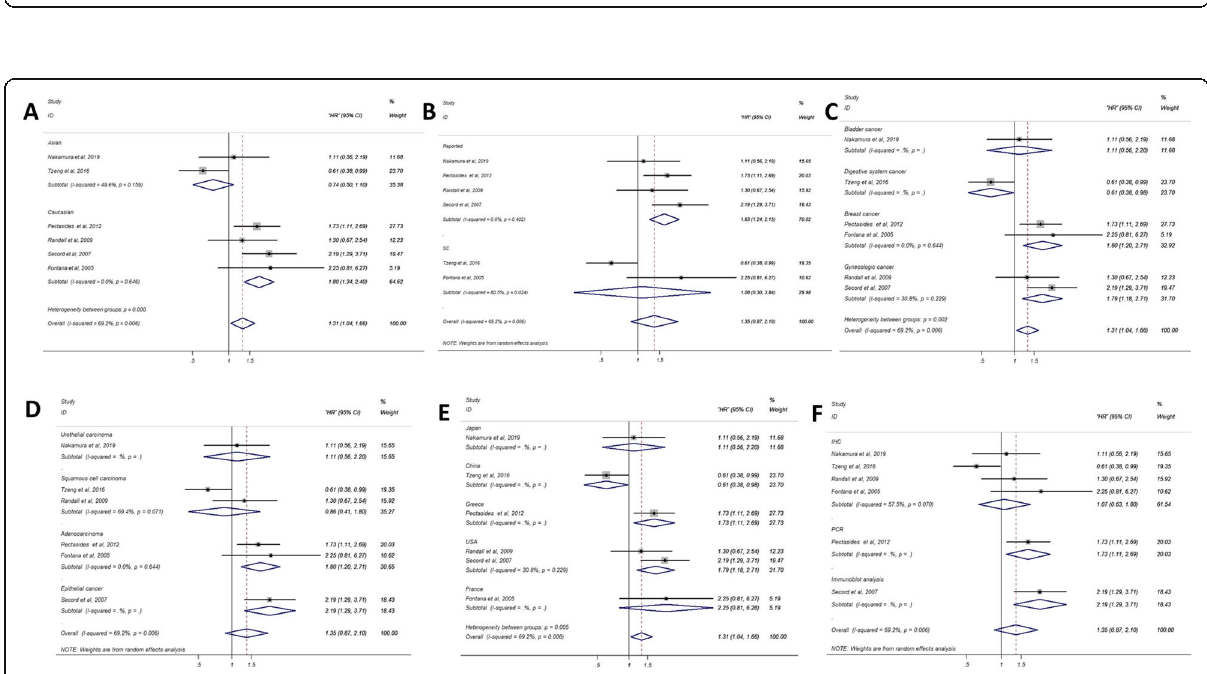
Fig. 3 Forest plots of merged analyses evaluated the correlation between OS and TSP-1 expression. (A) Forest plots for the subgroup analysis in different ethnicities; (B) Subgroup analysis in different source of HR; (C) Subgroup analysis in different disease types; (D) Subgroup analysis in different pathological types; (E) Subgroup analysis in different nationalities; (F) Subgroup analysis in different assay methods. Abbreviations: HR, Hazard ratio; SC: survival curve; PCR, polymerase chain reaction; IHC, immunohistochemistry; ELISA, enzyme linked immunosorbent assay